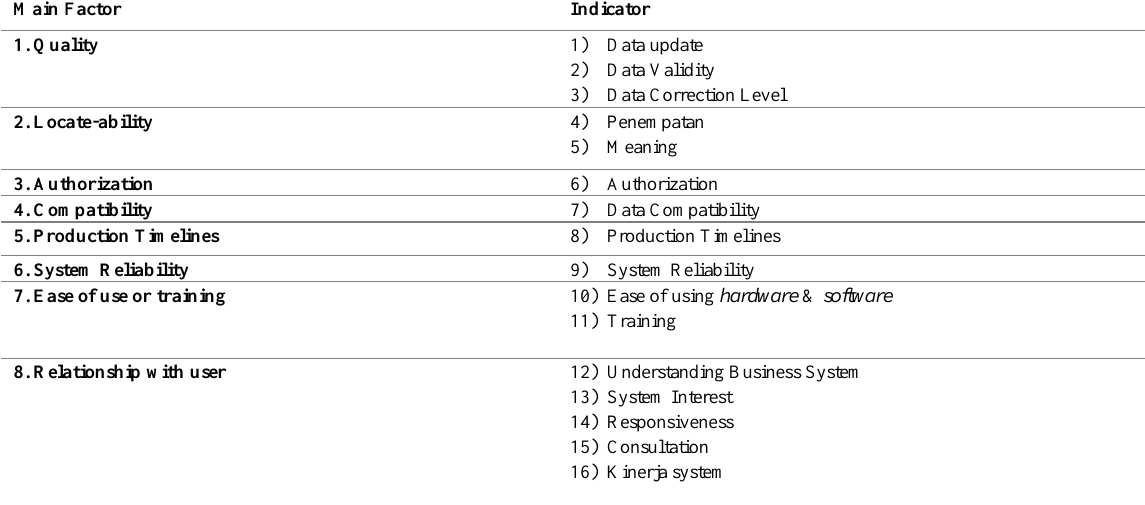
Table 1: Factors and Indicators of TTF